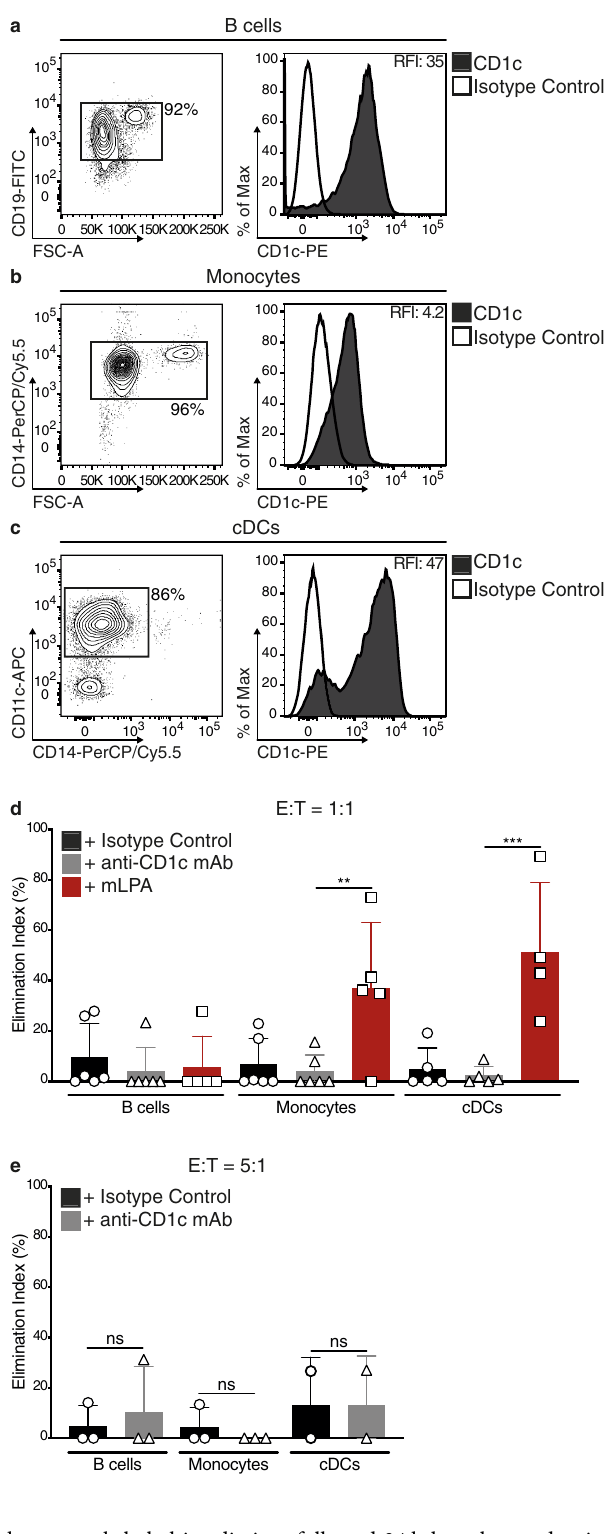
Fig. 6 DN4.99 TCR-T cells do not recognize normal CD1c + blood cells. Primary DN4.99 TCR-transduced T (DN4.99 TCR-T) cells were assessed for killing in vitro normal circulating CD1c + cells. a – c CD19 + B cells ( a ), CD14 + monocytes ( b ), and CD11c + circulating dendritic cells (cDCs, c ) were sequentially puri fi ed from the peripheral blood of healthy donors. Contour plots and histograms show the enrichment of each cell type